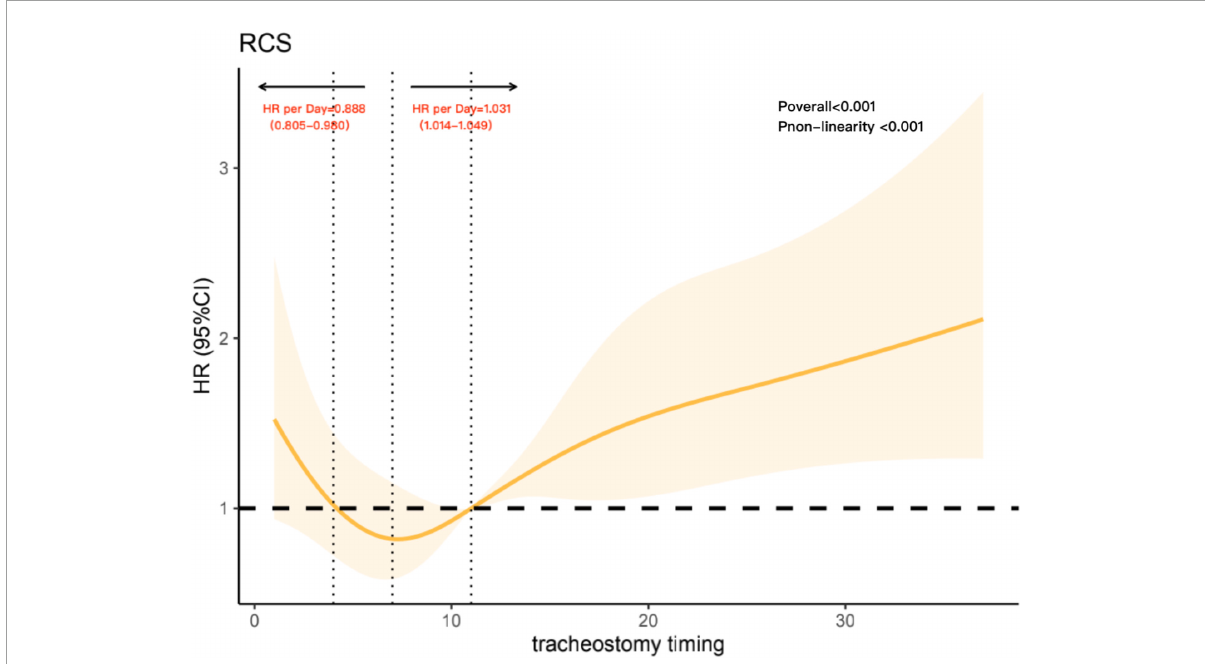
FIGURE3 Association with tracheostomy timing and mortality, adjusted variables including age, Simplified Acute Physiology Score (SAPS) II score, and Elixhauser Comorbidity Index (ECI) score. The reference point is the median tracheostomy timing and knots at the 5th, 27.5th, 50th, 72.5th, and 95th centiles of tracheostomy timing. The vertical line on the left shows tracheostomy timing around Day 4, while the vertical line in the middle shows tracheostomy timing around Day 8. The vertical line on the right shows tracheostomy timing on Day 11; it intersects the horizontal dotted line, and the intersection point represents the reference